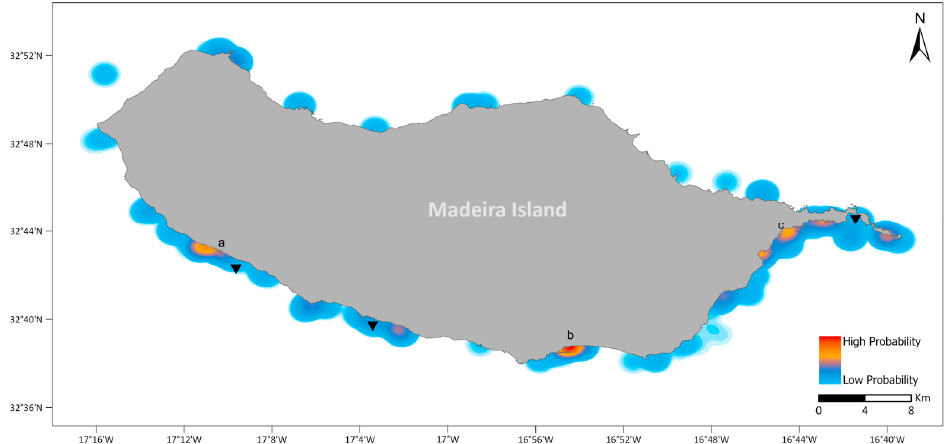
Figure 3. Heat map representing the reported probability of S. aurata sighting ( PSa ) according to the questionnaire survey. In red are the areas with high probability, while light blue represents areas with low probability values. The aquaculture facilities are represented as black triangles. Letters represent the three areas with a higher probability of S. aurata sightings: ( a ) Calheta; ( b ) Funchal; ( c ) Caniçal.